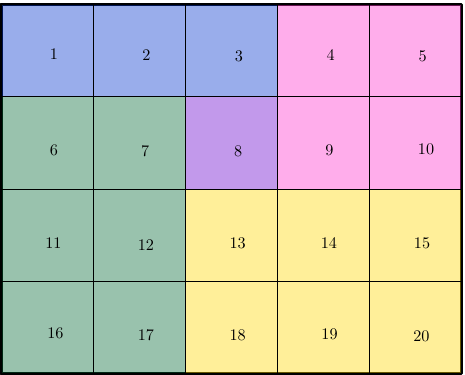
Figure 2. Example of a facility divided into five rectangular